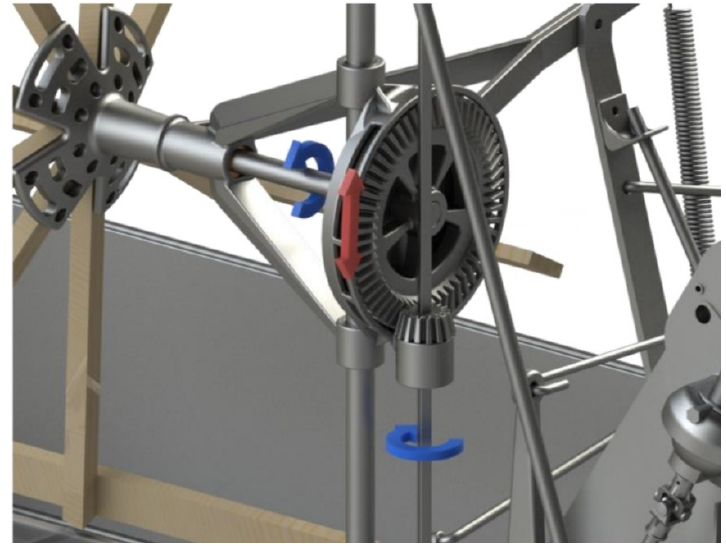
Figure 9. Description of the movement of the rotating pushers.